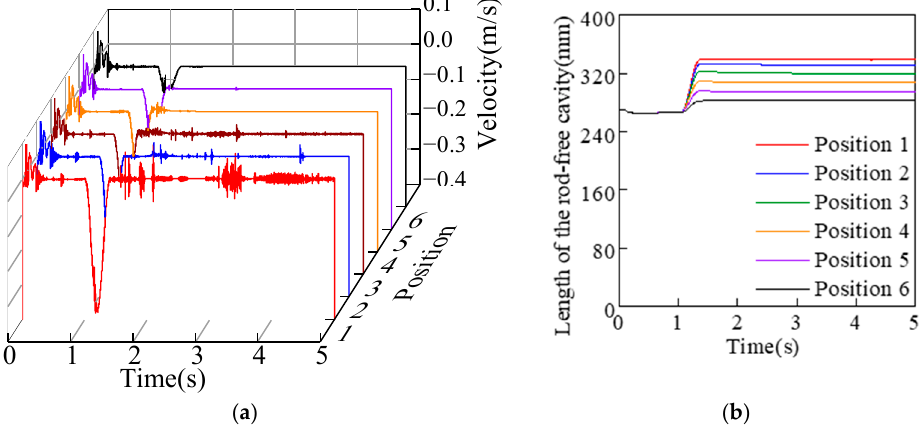
Figure 10. ( a ) Piston velocity at different rotation positions. ( b ) Length of the rod-free cavity at different rotation positions.